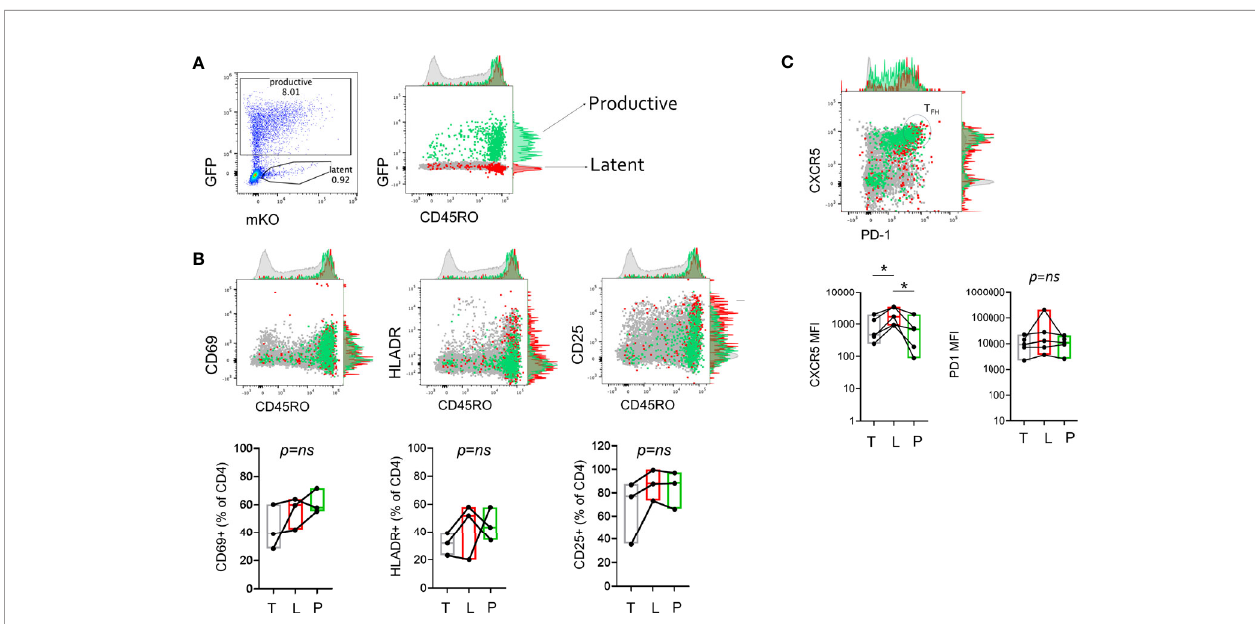
FIGURE 2 | Cellular activation and differentiation marker expression on productive and latent infected CD4 + T cells. (A) Measurement of memory marker CD45RO expression on productive (P, GFP+, green), Latent (L, GFP-mKO+, red), and total (T, light gray) CD4 + T cells 3 days post-infection with HIV GKO . (B) Representative plots showing expression of activation markers (CD69, HLADR, CD25) and CD45RO expression on productive, latent, and total cells. (C) Representative plot showing expression of TFH markers, CXCR5 and PD-1 on productive, latent, and total cells. CXCR5 hi PD-1 hi cells de fi ne TFH population. Box and whisker plots show data from 3-5 independent experiments (individual tonsil donors). Paired t-test analysis was performed to determine differences between the groups, *p < 0.05, ns, not signi fi